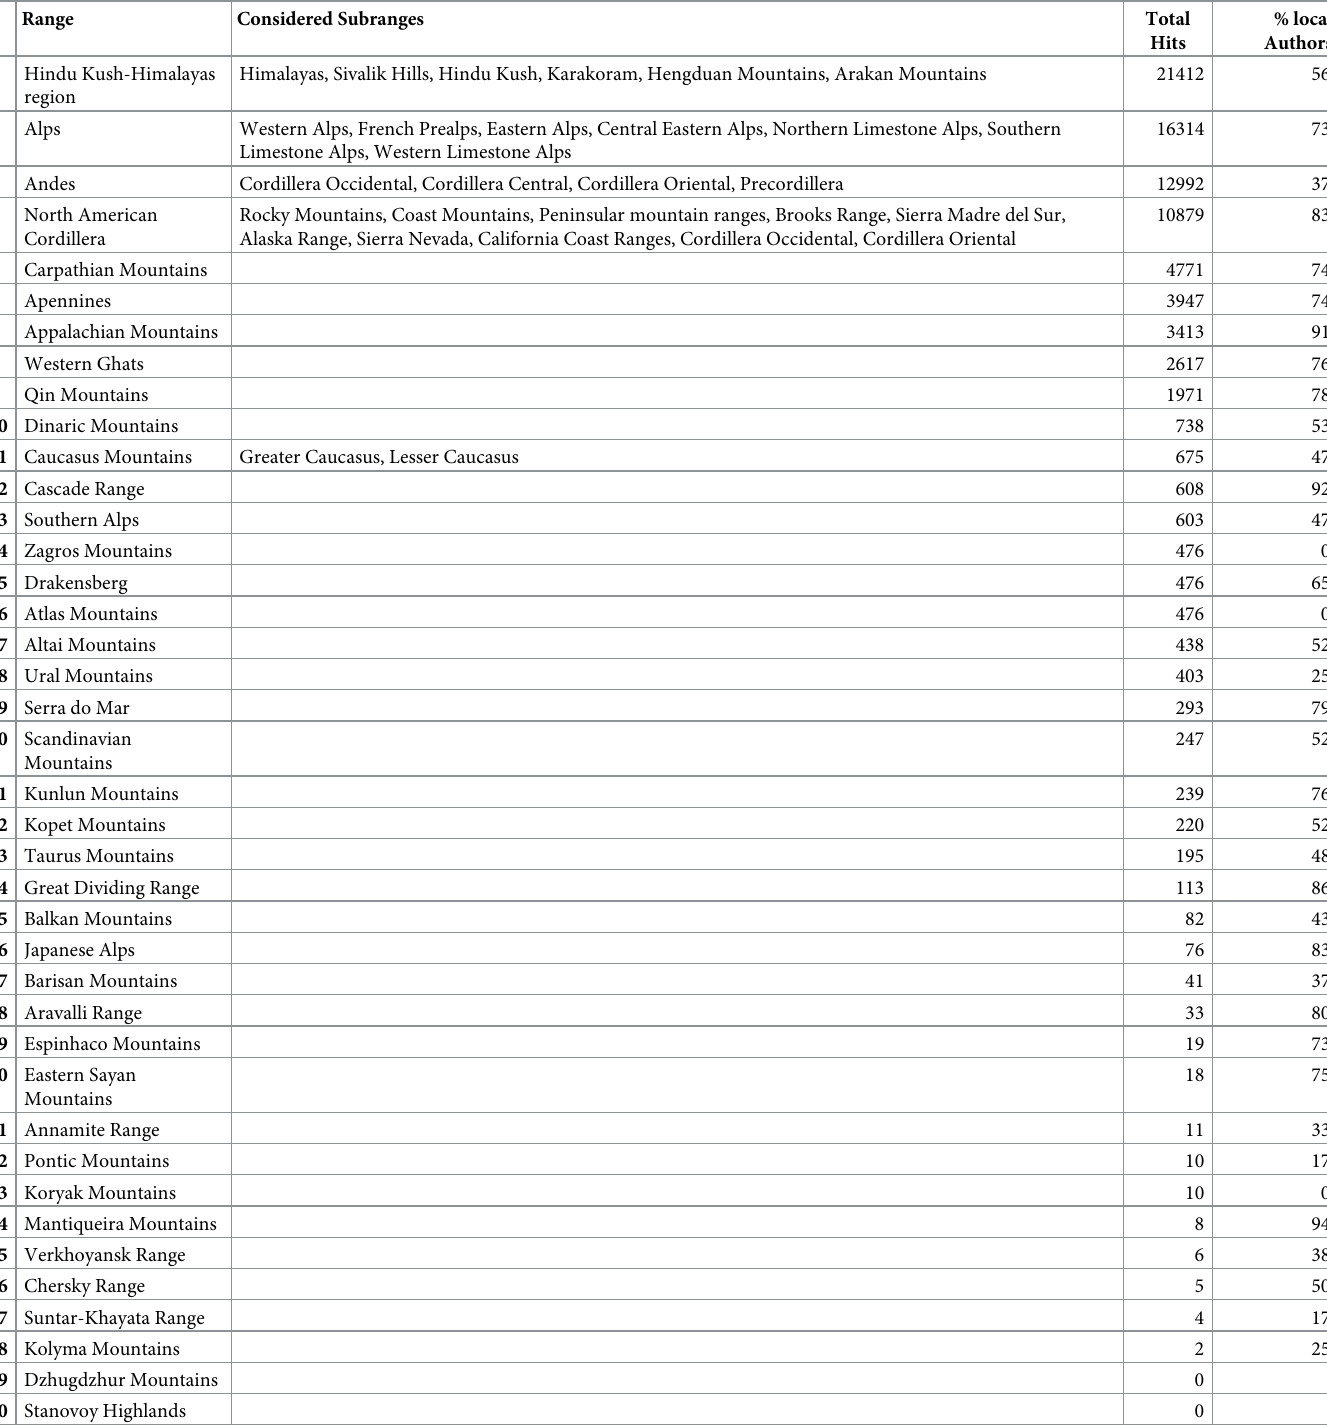
Table 2. Total hits per mountain range and percentage of paper authors based in local countries (countries that at least have some overlap with the range area).